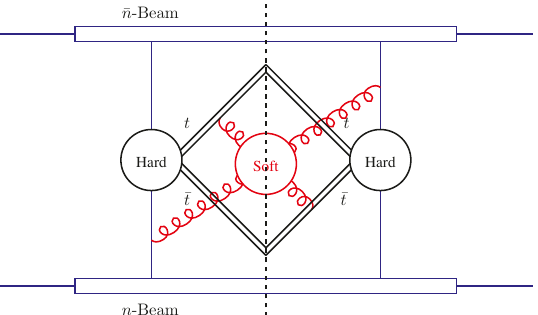
Figure 2 . Dynamic regions in the N J = 0 configuration. Herein, the black bubbles stand for the hard modes. The red bubble and springs encode the soft fluctuations connecting the heavy partons represented by the black double lines as well as the collinear modes depicted in the blue straight